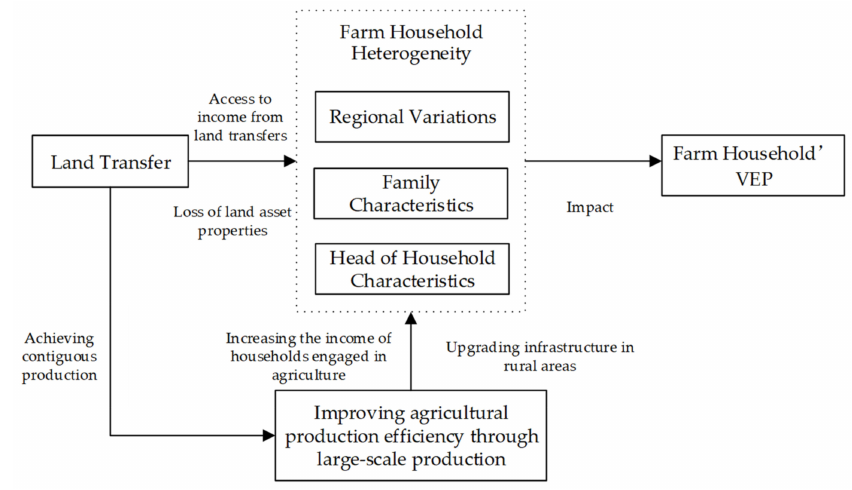
Figure 1. Mechanisms of the effect of land transfer on farm households’